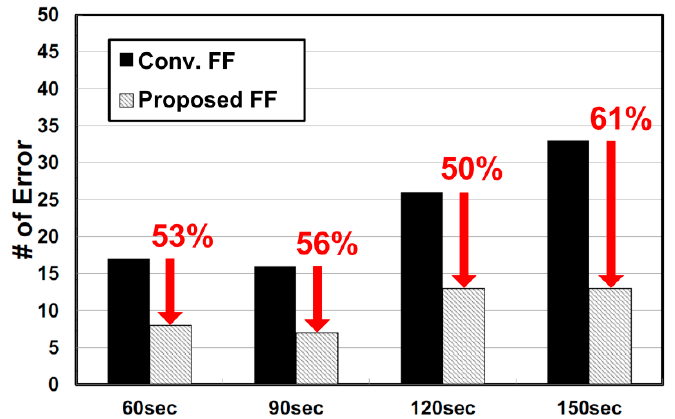
Figure 12. Measured number of data flip errors for 50,000 flip-flops (10,000 FF × 5 times = 50,000) in radiation environments.